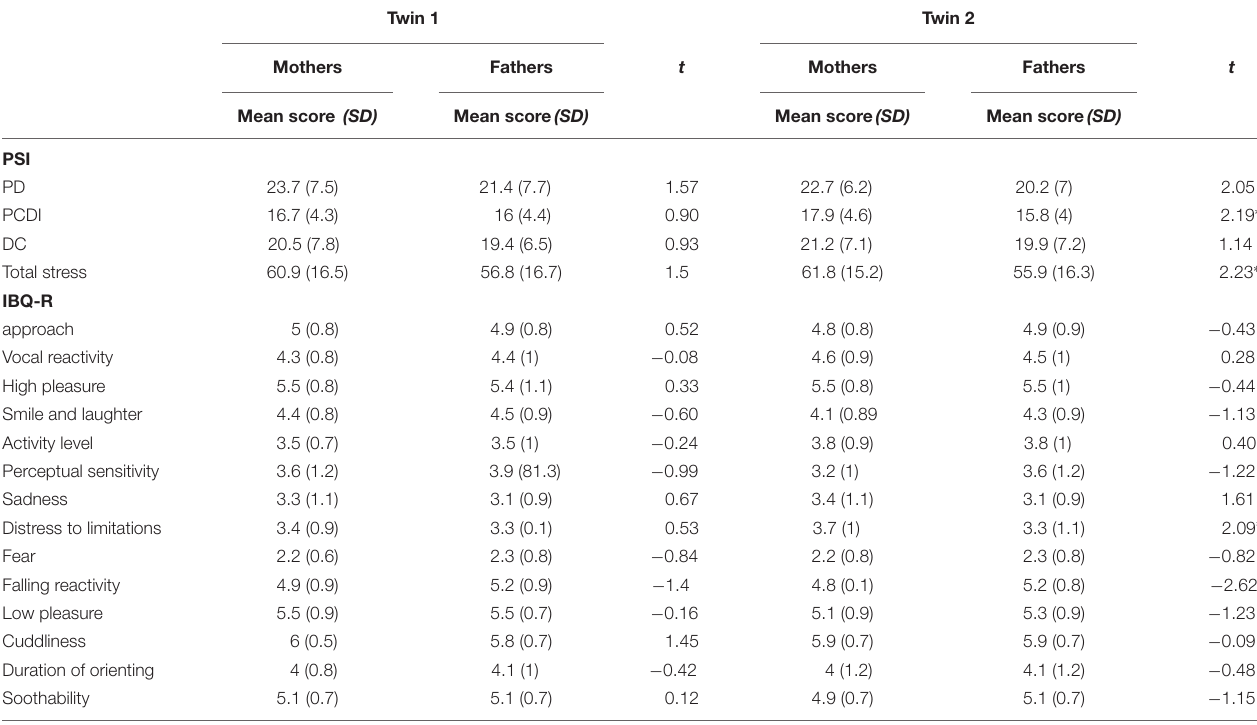
TABLE 4 | Distribution of outcomes by mother and father couples.